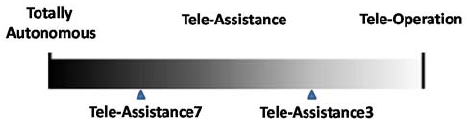
Figure 4. Various degrees of autonomy for the novice in three interactive strategies (Tele ‐ Operation, Tele ‐ Assisatnce3, and Tele ‐ Assistance7).